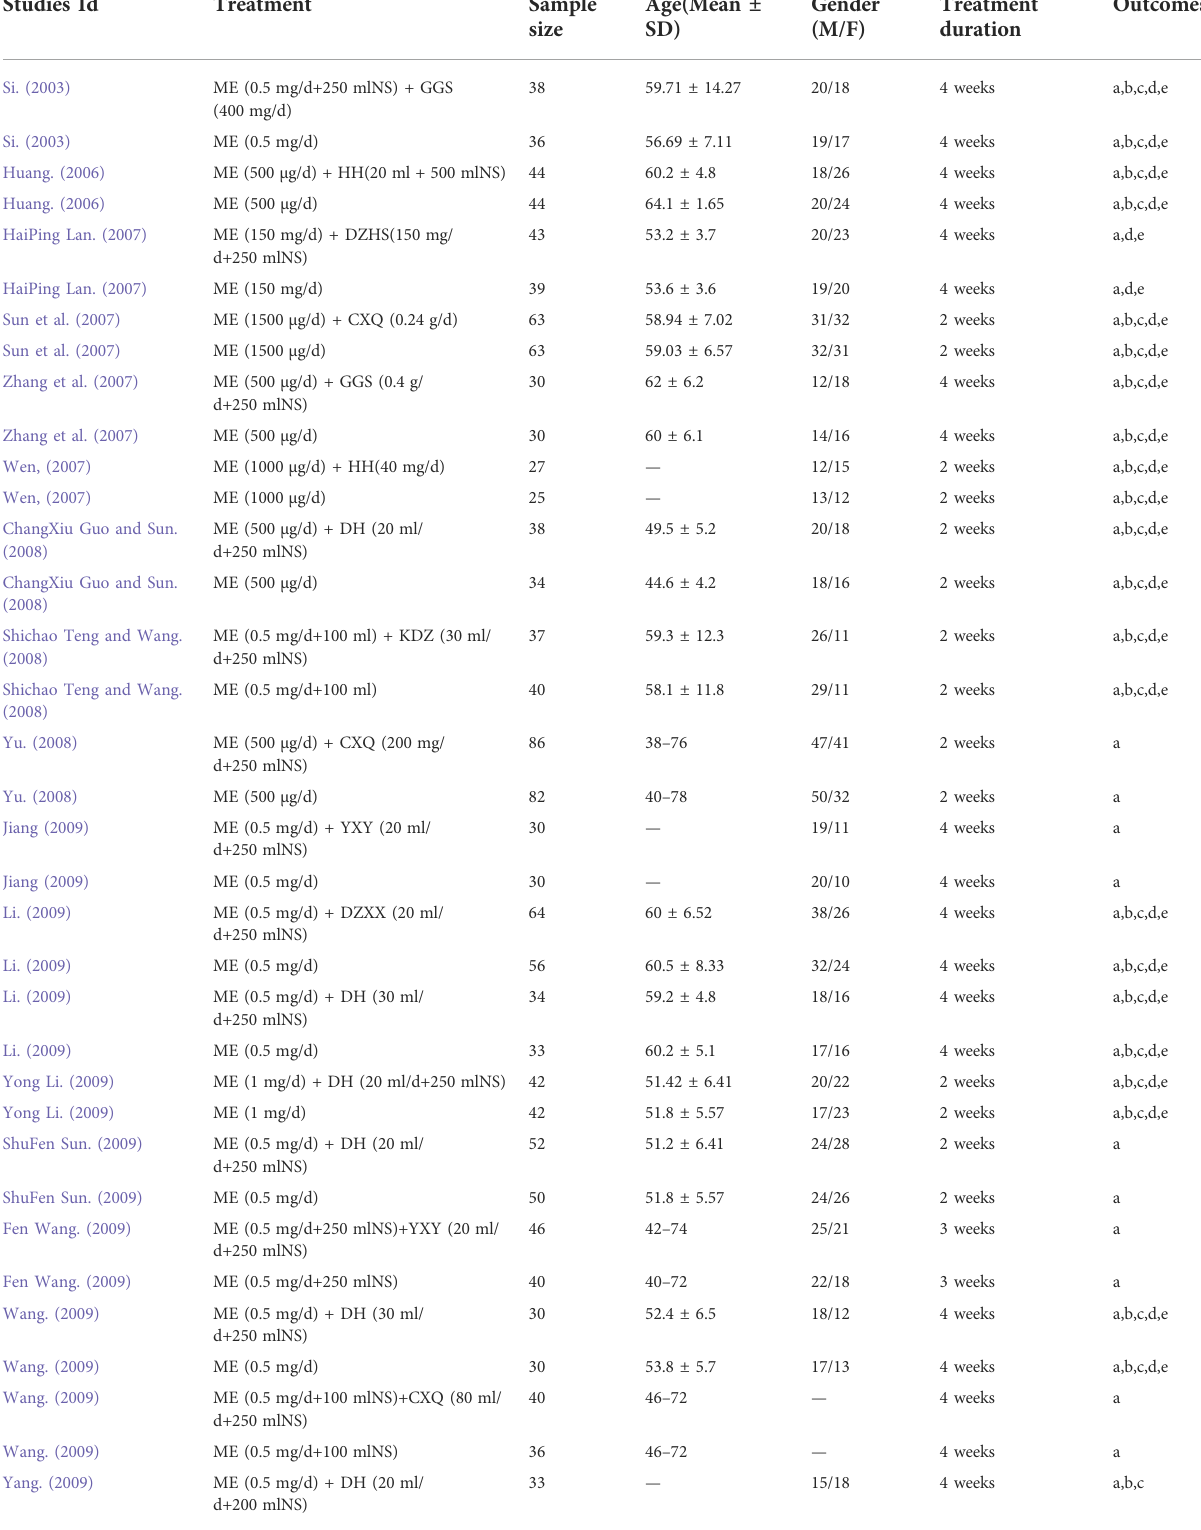
TABLE 1 Characteristics of included